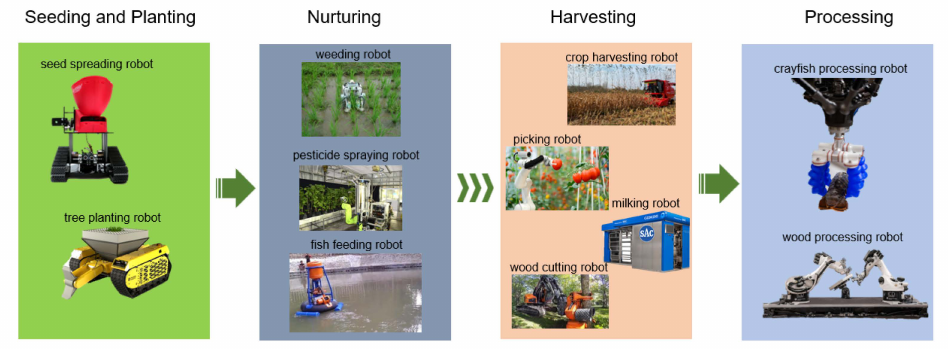
Figure 3. Agricultural robots along the industrial chain [13–17].